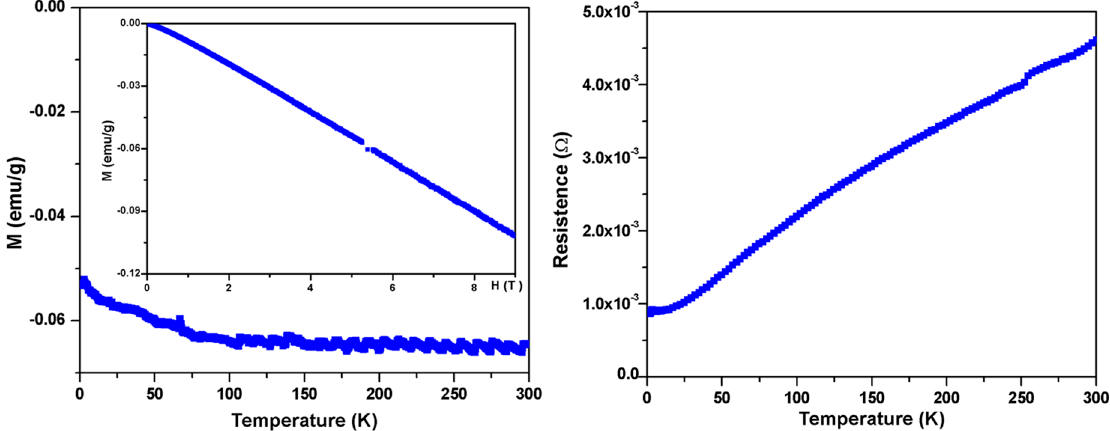
Figure 4. Basic electronic and magnetic characterization of BaIr 2 Ge 2 . ( Left: Main Panel) Temperature-dependent magnetic susceptibility (M/ μ 0 H at μ 0 H = 5 T) and ( Left: Inserted) field-dependent magnetization measurements showing the near linearity of M (magnetization) vs. H (magnetic field) for fields beyond 5 T at 1.8 K, justifying the use of the a high applied field in the measurements; ( Right ) Zero-field resistance data from 1.8 K to 300 K.